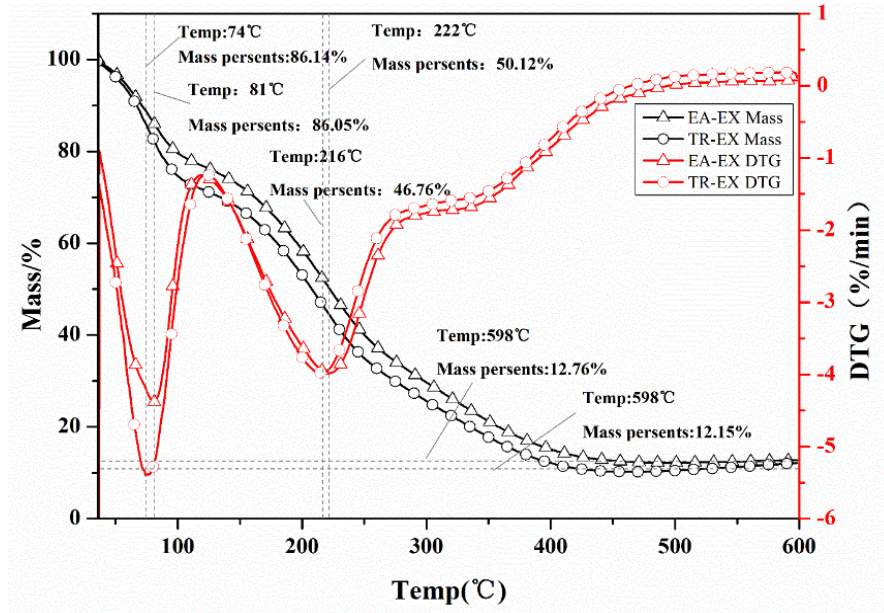
Figure 4. Thermogravimetric (TG) and differential thermogravimetric (DTG) curves of ethyl acetate extracts (EA-EX) and trichloromethane extracts (TR-EX) from Phoebe zhennan wood.